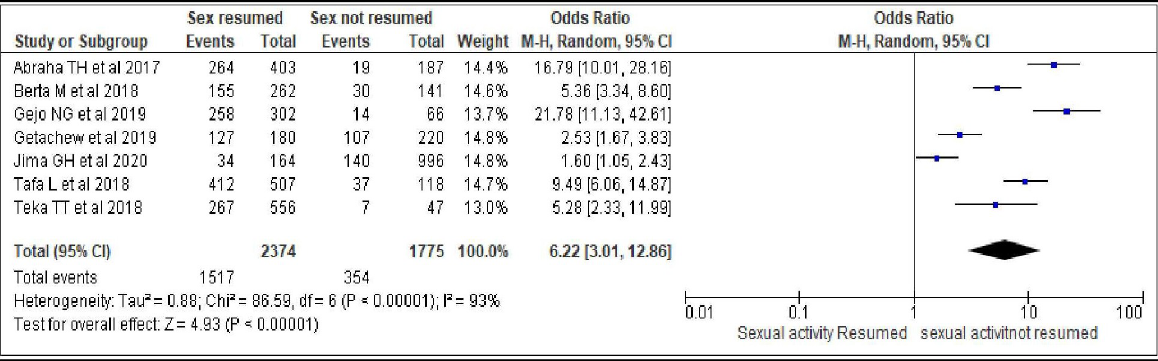
Fig 4. Association between resumption of sexual activity after birth and modern contraceptive uptake during postpartum period, 2021.